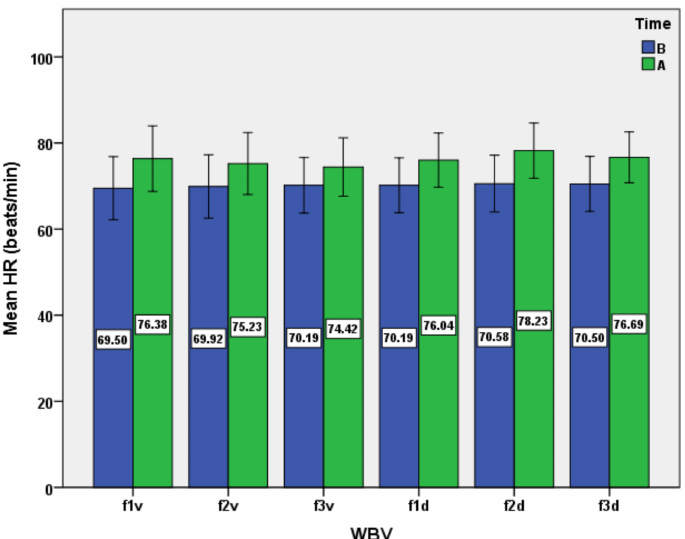
Figure 1. Impact of the WBV exposure on heart rate (HR) for the six protocols (means and standard deviations). B, before; A,